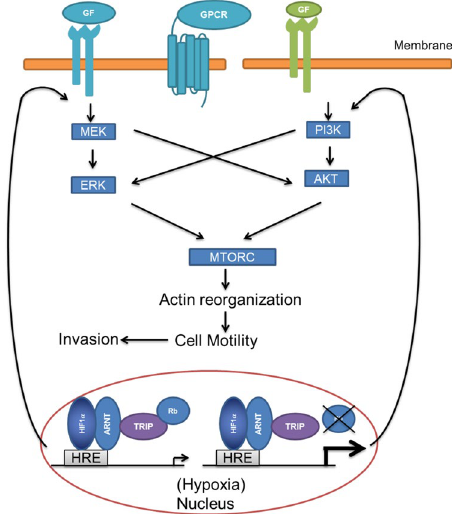
Figure 8. Signalling pathways responsible for changes in actin cytoskeleton. Loss of Rb in hypoxic prostate cancer cells increases actin reorganization and migration through ERK-AKT-MTOR signalling. GF: growth factor; GPCR: G protein coupled receptor; HRE: hypoxia response element; ARNT: aryl hydrocarbon receptor nuclear translocator; TRIP230: thyroid hormone receptor/retinoblastoma-interacting protein